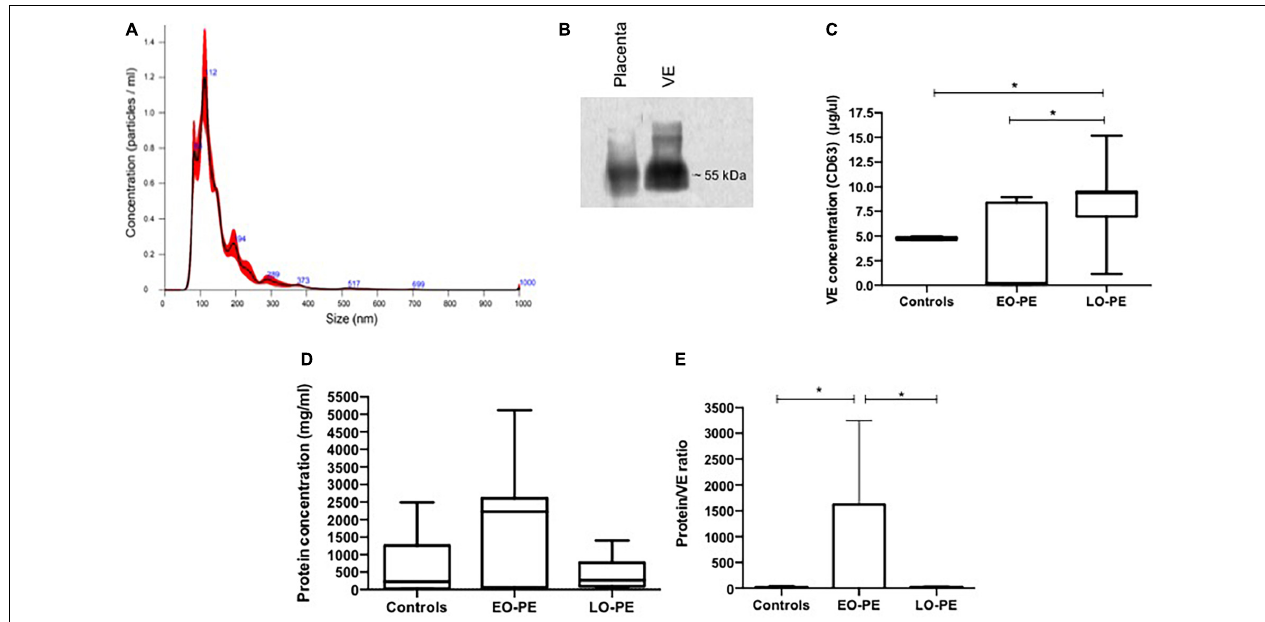
FIGURE 1 | VE characterization from explant culture supernatant. (A) Representative vesicle size distribution (nm) by NTA of VE. (B) Western blot analysis for the CD63 exosome marker. (C) Quantification of VE by ELISA measuring CD63 (controls vs. EO-PE p = 0,2069; controls vs. LO-PE p = 0,0262; EO-PE vs. LO-PE: p = 0,0175). (D) Quantification of protein within VE by Bradford method (controls vs. EO-PE p = 0,2069; controls vs. LO-PE p = 0,6031; EO-PE vs. LO-PE: p = 0,3129). (E) Analysis of ratio of protein quantity by VE (controls vs. EO-PE p = 0,0175; controls vs. LO-PE p = 0,3759; EO-PE vs. LO-PE: p = 0,0262) * p ≤